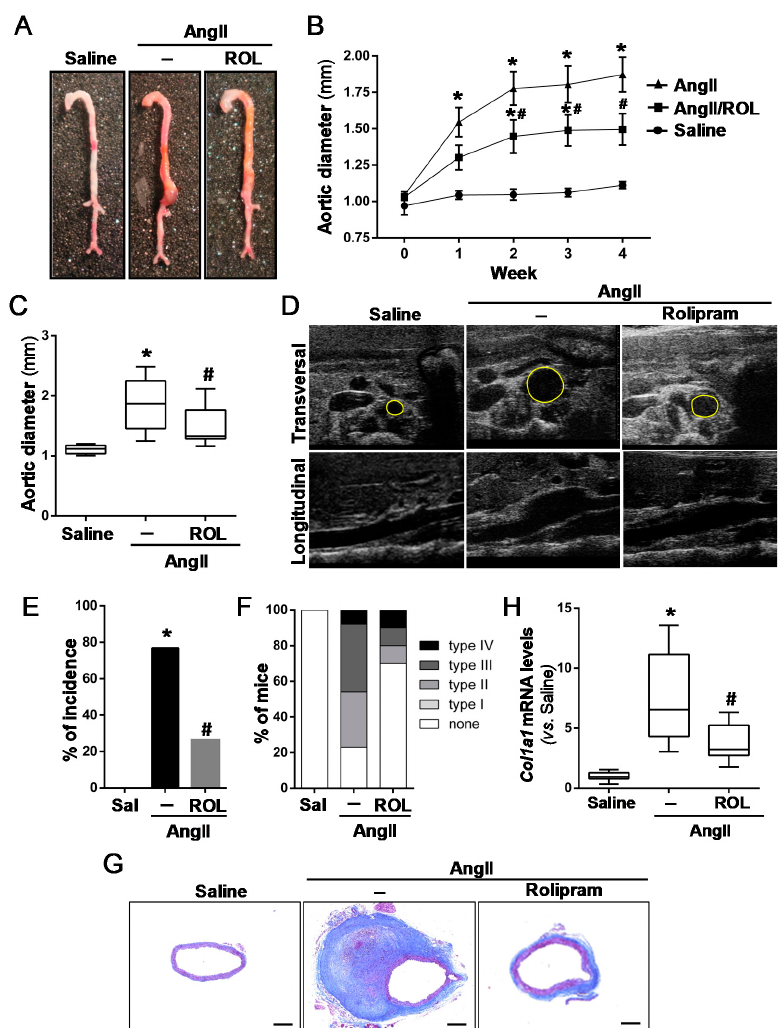
Figure 3. Rolipram ameliorates AAA development in AngII-infused ApoE − / − mice. ApoE − / − mice were infused with saline solution (Sal) or AngII (1000 ng/kg/min) for 28 days. The mice challenged with AngII were treated or not with rolipram (ROL, 3 mg/kg/day). ( A ) Representative macroscopic images of the aortas from each experimental group. ( B ) Time-course analysis of the abdominal aortic diameter by ecochardiography. The data are mean ± SEM (saline-infused mice, n = 9; AngII-infused animals, n = 13; AngII-infused mice treated with rolipram, n = 10). p < 0.05: * vs. saline-infused mice; # vs. AngII-challenged mice. ( C ) Quantitative analysis of the aortic diameter at the end of the experimental period (28 days). The results are expressed as boxplots. The box extends from the 25th to the 75th percentile, and the median is indicated by a horizontal line. The whiskers represent the maximum and minimum values. p < 0.05: * vs. saline-infused mice at the same time; # vs. AngII-challenged mice. ( D ) Representative ultrasonographic frames after 28 days of AngII infusion. Transverse and longitudinal images taken at the level of the suprarenal aorta are shown. The aortic diameter is indicated with a yellow line. ( E ) Incidence of AAA in each experimental group. p < 0.05: * vs. saline-infused mice; #vs. AngII-challenged mice. ( F ) The aneurysm severity based on the Manning scale. ( G ) Masson trichrome staining of the abdominal aortas from each group. Representative images are shown. Bars: 200 µ m. ( H ) The Col1A1 mRNA levels assessed in these samples by real-time PCR. The data are presented as box and whisker plots. The box extends from the 25th to the 75th percentile, and the median is indicated by a horizontal line. The whiskers represent the maximum and minimum values (saline-infused mice n = 8; AngII-challenged mice, n = 12; AngII-challenged mice treated with rolipram, n = 8). p < 0.05; * vs. saline-infused mice; # vs. AngII-challenged